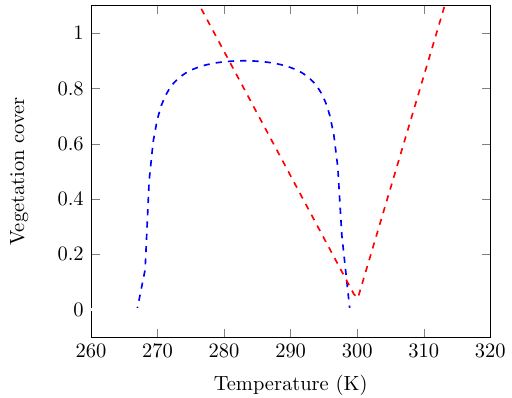
Figure 5. The model’s phase plane with the two nullclines (dashed lines) and the three fixed points (open and filled dots); the two filled dots are stable, while the open one is unstable. The stable manifold of the saddle (open dot) is shown in black and the unstable one in magenta. The coordinates of the fixed points are (242.04, 0) for the unvegetated state, and (280.8, 0.898) and (297.9, 0.129) for the unstable and stable vegetated states,